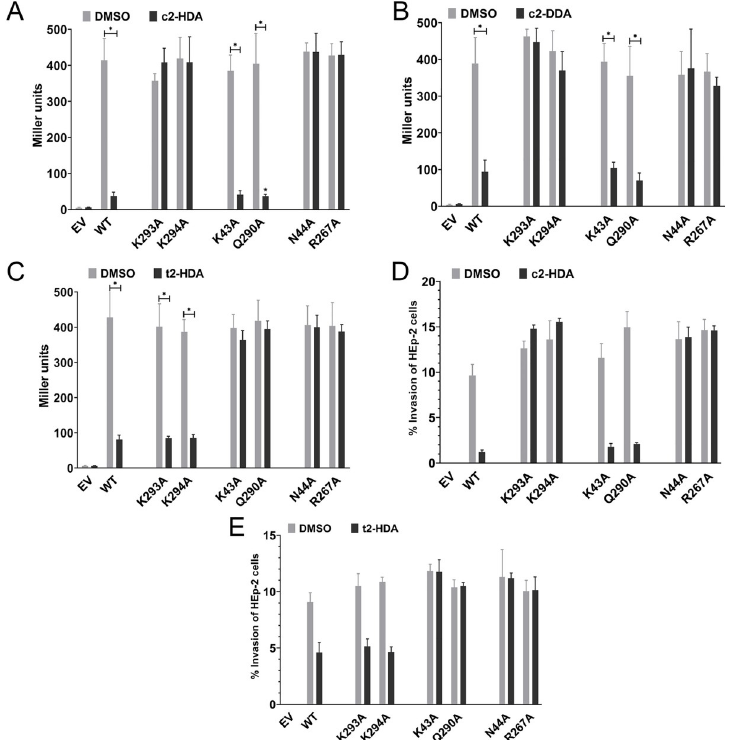
Fig 2. Specific amino acid residues of HilD are essential for repression by c2-HDA. (A-C) Salmonella strains expressing empty vector (EV) or wild type (WT) or mutant HilD were grown in the presence of 20 μ M c2-HDA (A), c2-DDA (B), or t2-HDA (C) and expression of the invasion gene sipB was measured using a lacZY transcriptional reporter fusion, by β -galactosidase assays. Bars represent mean ± SD (n = 4). Differences between respective DMSO controls and fatty acid treatments were calculated by Mann-Whitney test, � p < 0.05. (D-E) Strains were grown in the presence of 20 μ M c2-HDA (D) or t2-HDA (E) and invasion of HEp-2 cells was measured by gentamicin protection assay. Data show mean ± SD (n =